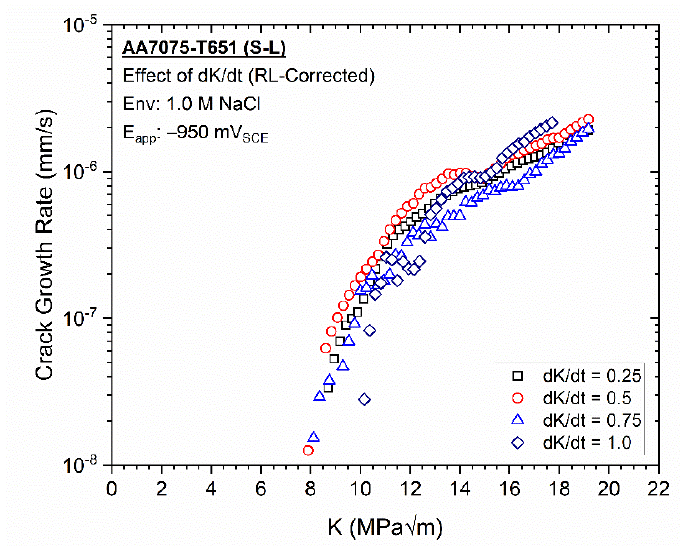
Figure 4. Effect of dK/dt on the crack growth rate versus stress intensity relationships for AA7075- T651 in 1.0 M NaCl at an applied potential of − 950 mV SCE .